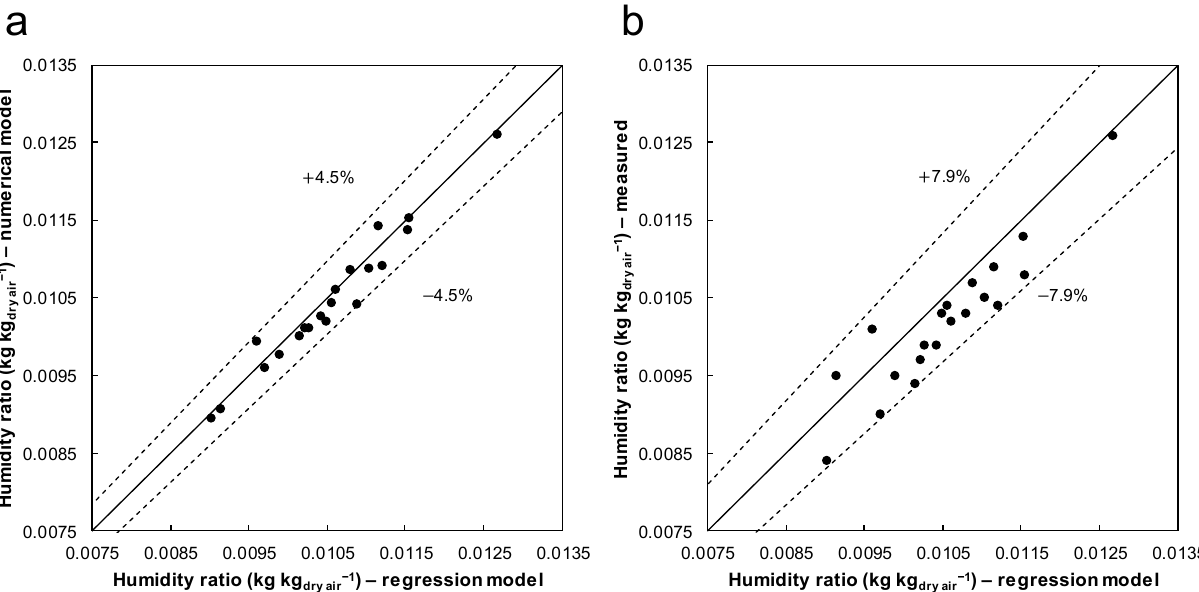
Figure 6. ( a ) Comparison between the predicted supply air outlet humidity ratio by the regression and numerical models and ( b ) comparison between the regression model’s predictions of supply air outlet humidity ratio and measurements.